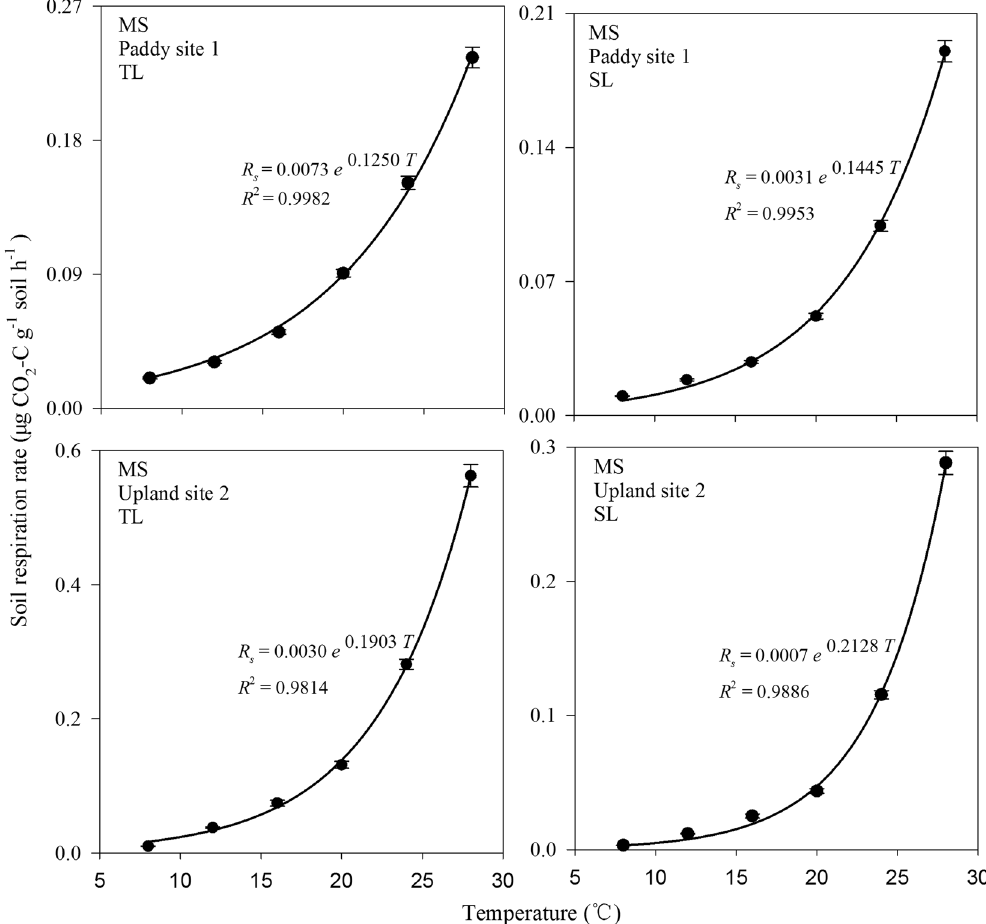
Figure 1. Variation of respiration rate with incubation temperature. Error bars indicate standard deviation (n = 4). TL, SL, and MS represent topsoil layer, subsoil layer, and Meishan,